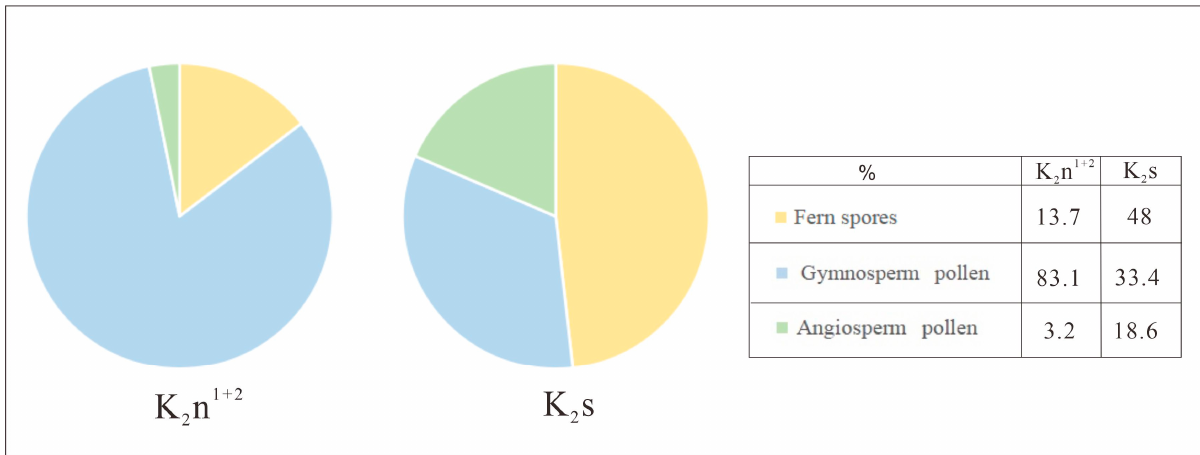
Figure 8. Ratio of different types of palynomorphs in borehole ZKY2-1.